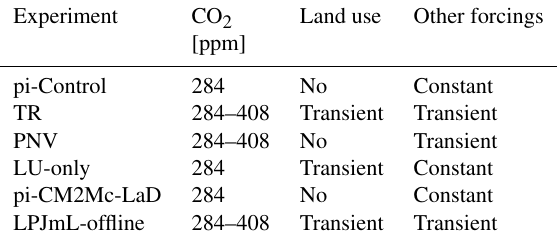
Table 1. Overview of the simulation experiments conducted in this study. All runs, except for pi-CM2Mc-LaD and LPJmL-offline, are performed with CM2Mc-LPJmL. Other forcings include aerosols, non-CO 2 greenhouse gases, ozone and the solar constant. In the case of non-transient simulations, these are kept constant at their values from the year 1860. Land use can either be transient (i.e., capturing historical changes) or be